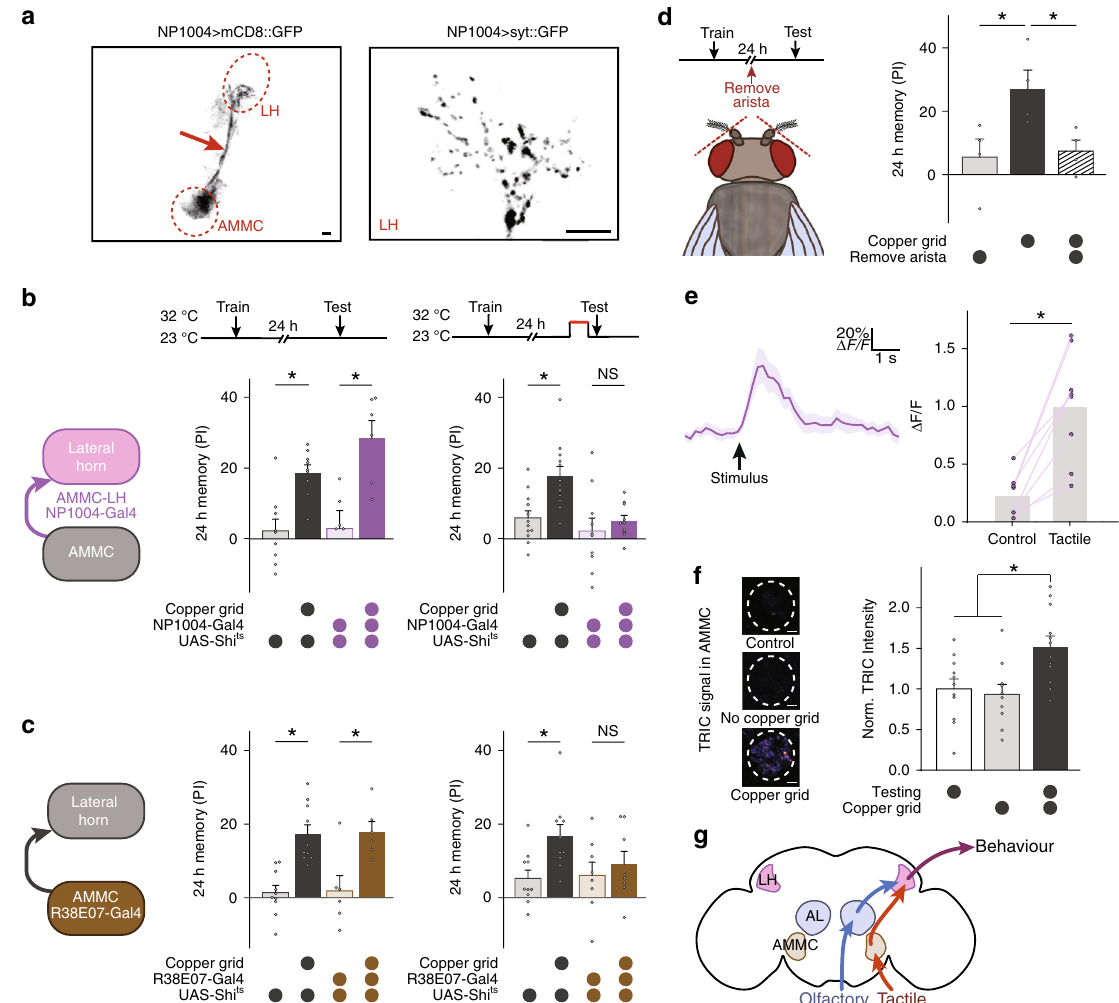
Fig. 4 Retrieval of cLTM requires AMMC and AMMC-LH neurons. a Left: The expression pattern of NP1004-Gal4. The neurons that connect the antennal mechanosensory and motor centre (AMMC) and lateral horn (LH) are broadly labelled (arrow). Right: The presynaptic marker syt::GFP driven by NP1004- Gal4 is highly concentrated in the LH region. Scale bar = 20 μ m. b Left: Schematic of R38E07-Gal4 AMMC neurons. Right: Blockade of R38E07 neurons during testing abolishes cLTM retrieval ( n = 6 – 12). c Left: Schematic of NP1004-Gal4 AMMC to lateral horn neurons. Right: Blockade of NP1004